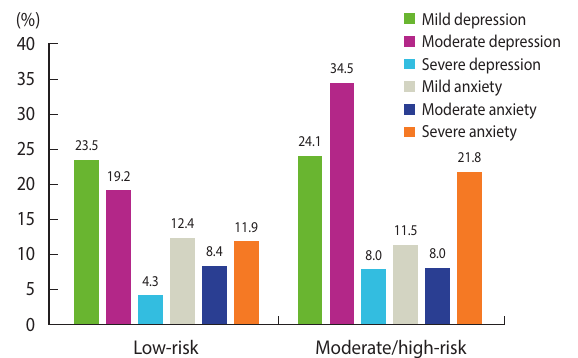
Figure 1. Levels of depression and anxiety according to 10-year car- diovascular risk. Depression was divided into mild depression (12-19 points), moderate depression (20-35 points), and severe depression (≥ 36 points); Anxiety was divided into mild anxiety (52-56 points), moderate anxiety (57-61 points), and severe anxiety (≥62 points); To estimate the 10-year cardiovascular risk, the Framingham risk score (based on age, gender, smoking, blood pressure, total cholesterol, high-density lipoprotein cholesterol, and diabetes mellitus) was calculated, and participants were divided into low-risk (<10%) and moderate/high-risk (≥10%) groups. Table 1. Difference in participants’ characteristics and depression/anxiety in accordance between 10-year cardiovascular risk groups (n=457) Variables